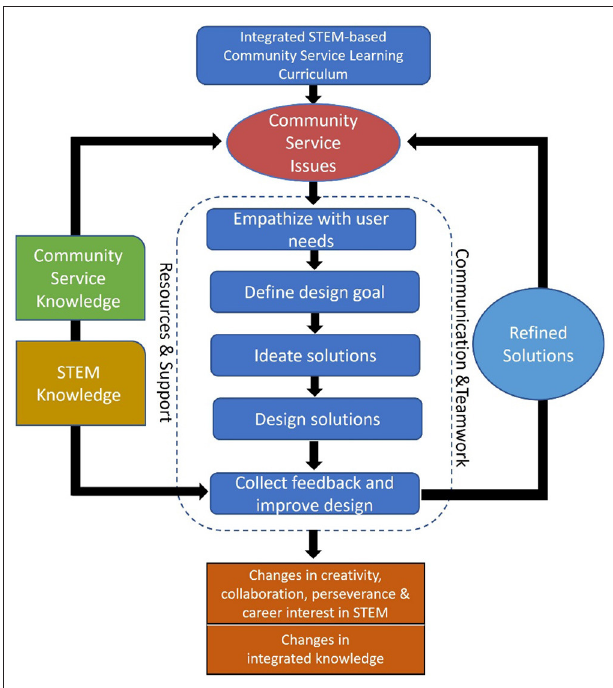
FIGURE 1 | The integrated STEM-based community service-learning model. integrated STEM courses (see Figure 1 ). The model depicted the main components for supporting individual or team creativity in K-12 setting, such as resources and support from school level, and opportunity to learn relevant domain knowledge.